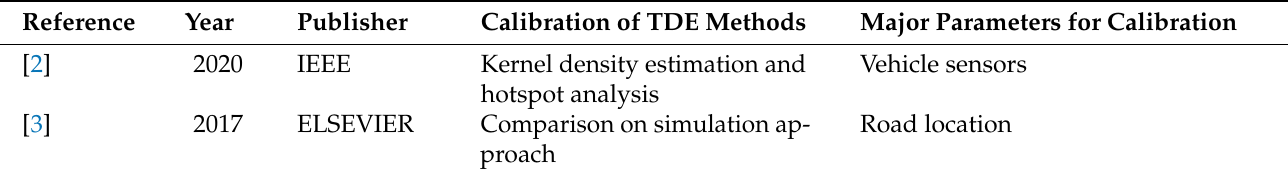
Table 2. Traffic density estimation